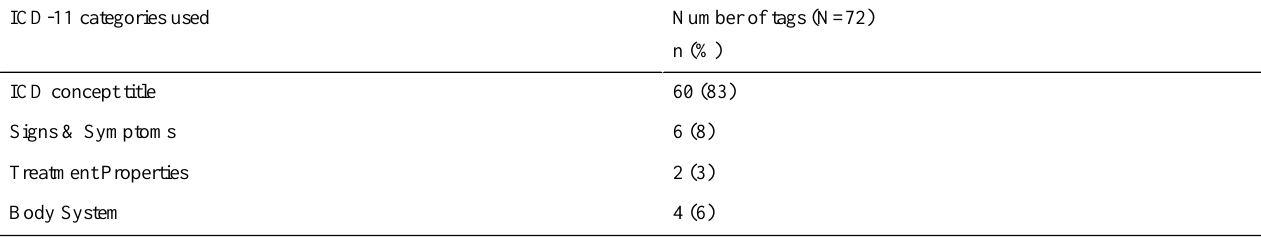
Table 4. Distribution of tags over ICD-11 categories (for the gastroenterology blog).